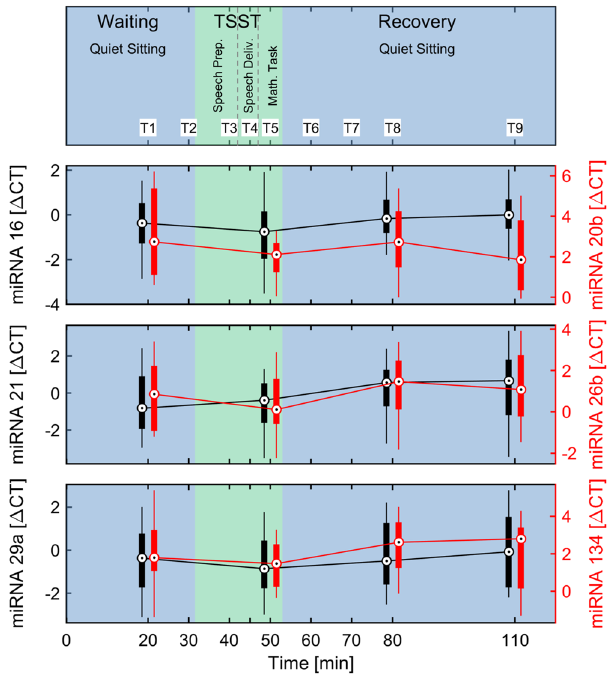
Figure 2. C ourse of salivary miRNAs. The central circle represents the median; the boxplots represent the distribution from 25%- to 75%-percentile. The Whiskers represent remaining data distribution from minimum to